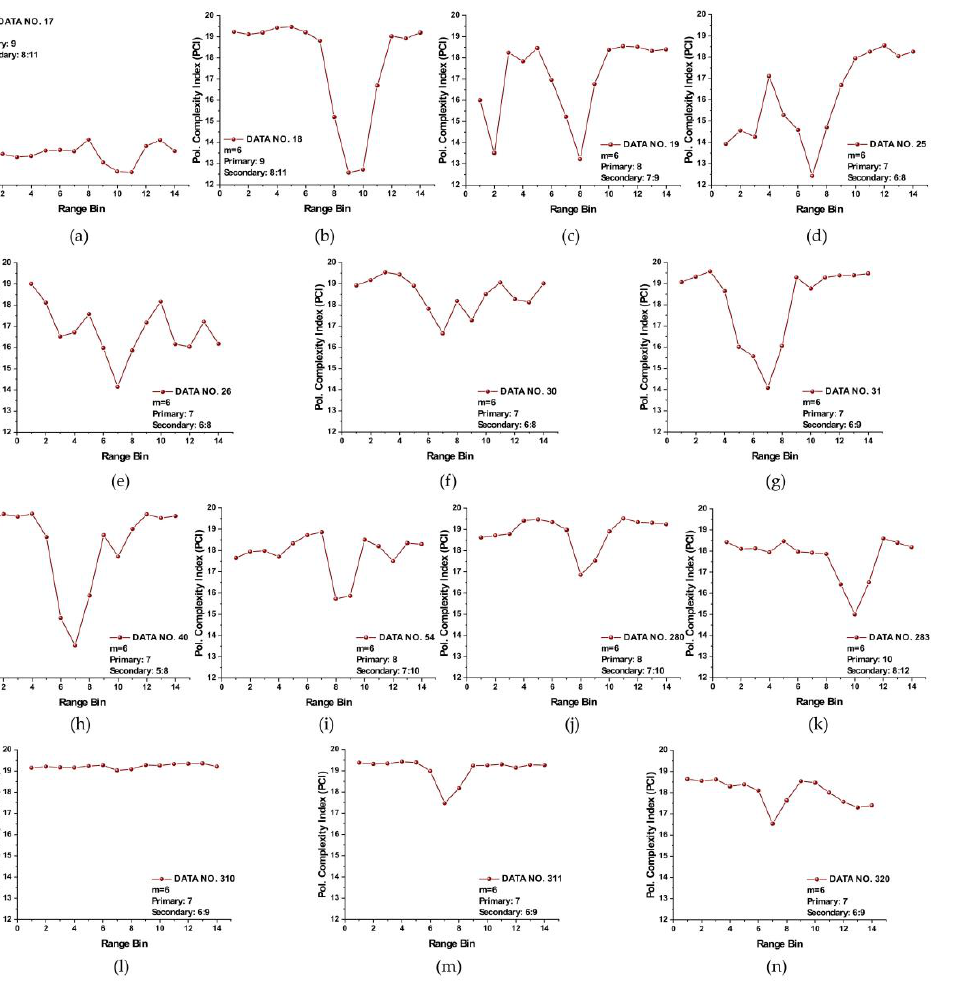
Figure 11. ( a – n ) The polarized complexity index (PCI) of 14 data sets at template vector length m = 6 · ( τ = 20, r = 0.15 ∗ std { s } )